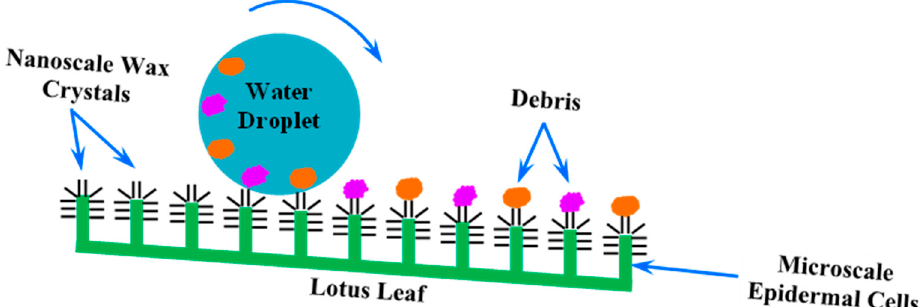
Figure 2. A simple schematic for understanding of the lotus effect. The water droplet collects the debris as it descends from the leaf. The figure has been created by the authors based on the concept illustrated by Poole [27].